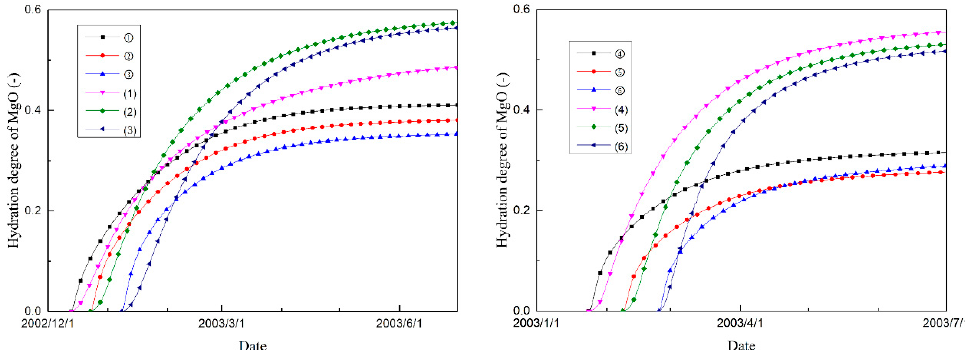
Figure 10. Magnesium oxide hydration degree histories of different typical points.